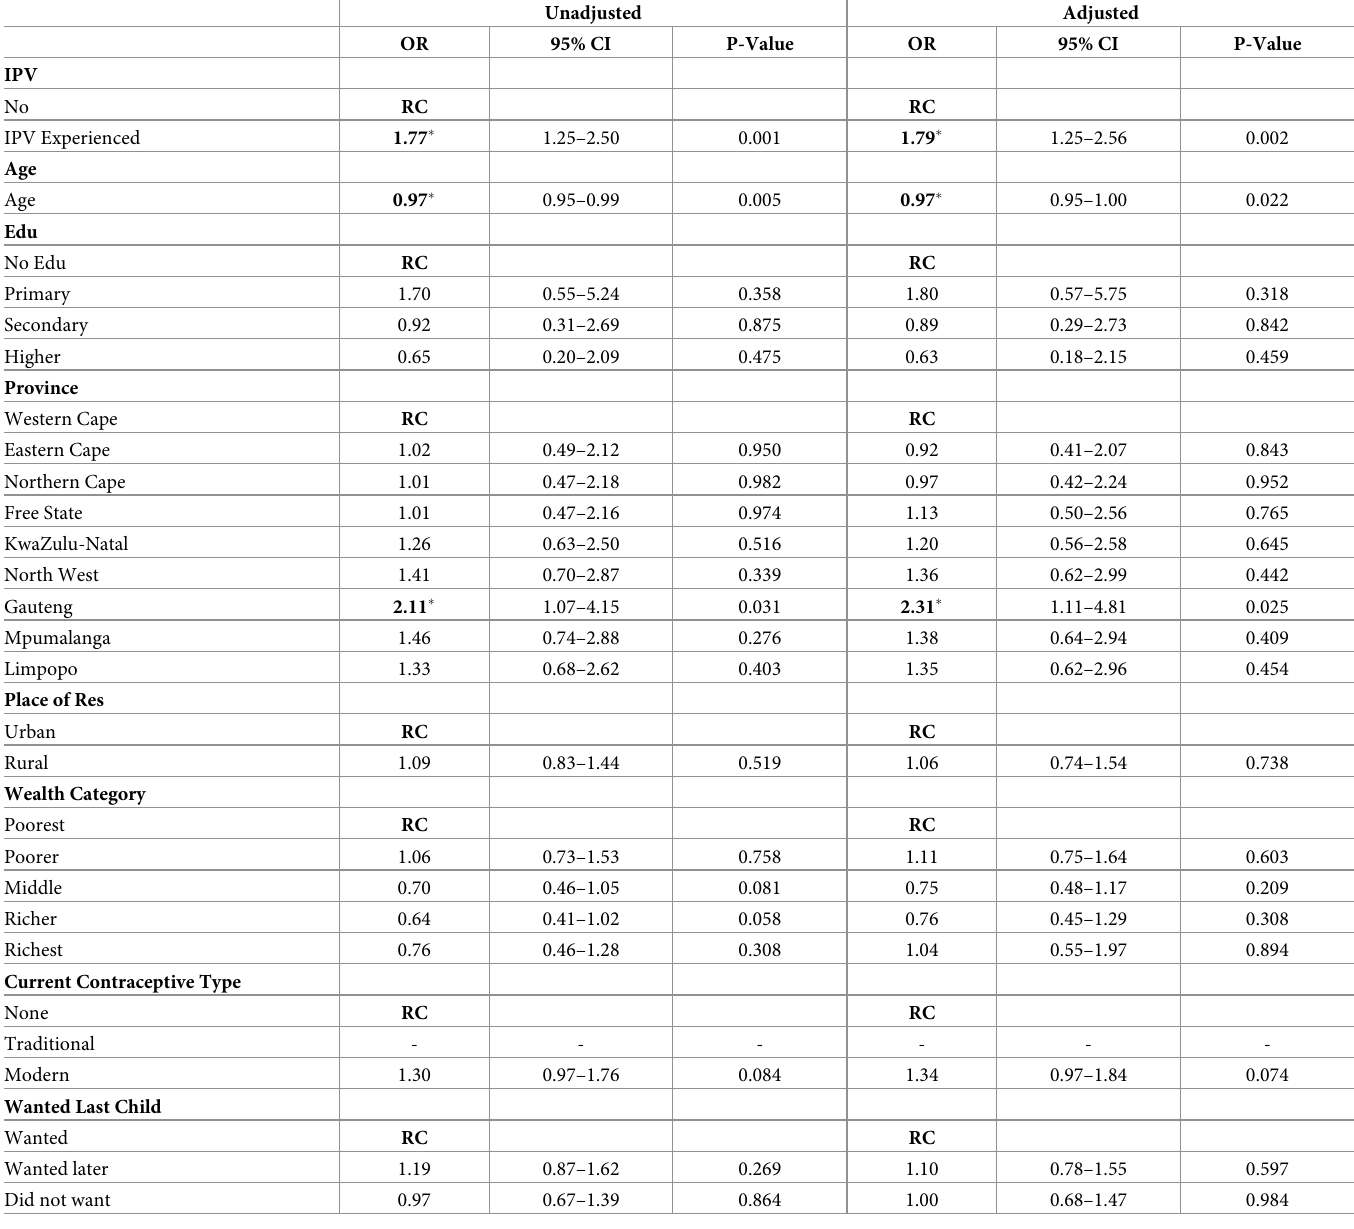
Table 6. Unadjusted and adjusted regression for diarrhoea in the last 2